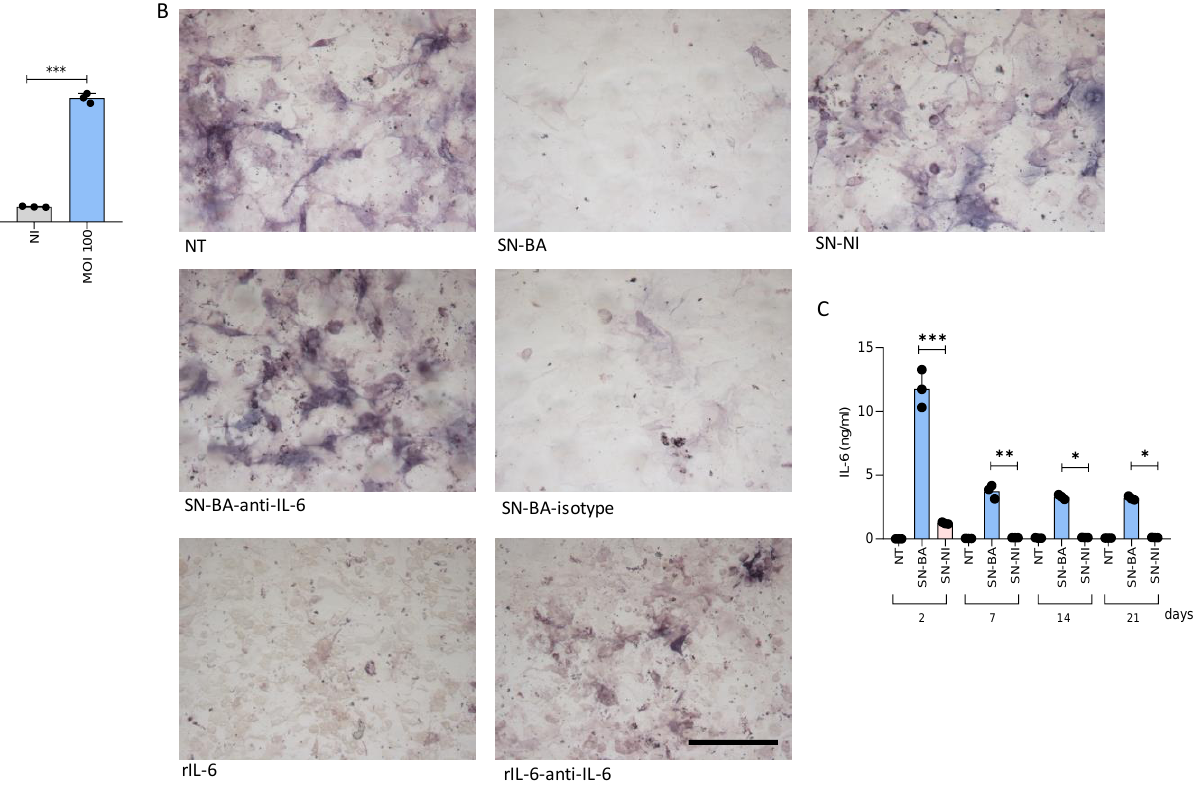
Figure 2. B. abortus -infected adipocytes inhibit osteoblast differentiation largely due to IL-6. IL-6 in adipocyte culture supernatants were detected by ELISA 24 h after B. abortus infection ( A ). Pre-osteoblasts were differentiated in the presence of culture supernatants from B. abortus -infected adipocytes at MOI 100 (SN-BA) or culture supernatants from non-infected adipocytes as control (SN-NI). Supernatants were incubated with an anti-IL-6 neutralizing antibody (SN-Ba-anti-IL-6) or isotype control (SN-BA-Isotype). Recombinant mouse IL-6 (rIL-6, 1 ng/mL) was used as a positive control. Osteoblast differentiation was measured by staining ALP activity ( B ). IL-6 secretion was measured at different times during the osteoblast differentiation process carried out in the presence of culture supernatants from B. abortus -infected adipocytes at MOI 100 (SN-BA) or culture supernatants from non-infected adipocytes (SN-NI) by ELISA ( C ). NT: non-treated. Scale bar: 50 µ m. * p < 0.001, ** p < 0.001, and *** p < 0.0001 vs. cells treated with culture supernatants from non-infected cells (SN-NI).